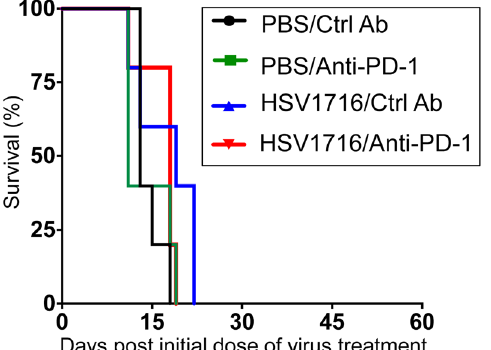
Figure 3. Combination therapy loses antitumor efficacy in nude mice. Female nude mice were implanted with 5 × 10 6 M3-9-M cells subcutaneously and treated with three intratumoral injections of 10 8 pfu HSV1716 followed by intraperitoneal injections of anti-PD-1 antibody as described in Fig. 1a. Kaplan-Meier survival curves for each treatment group (n = 5 per treatment group) demonstrate that combination therapy lost